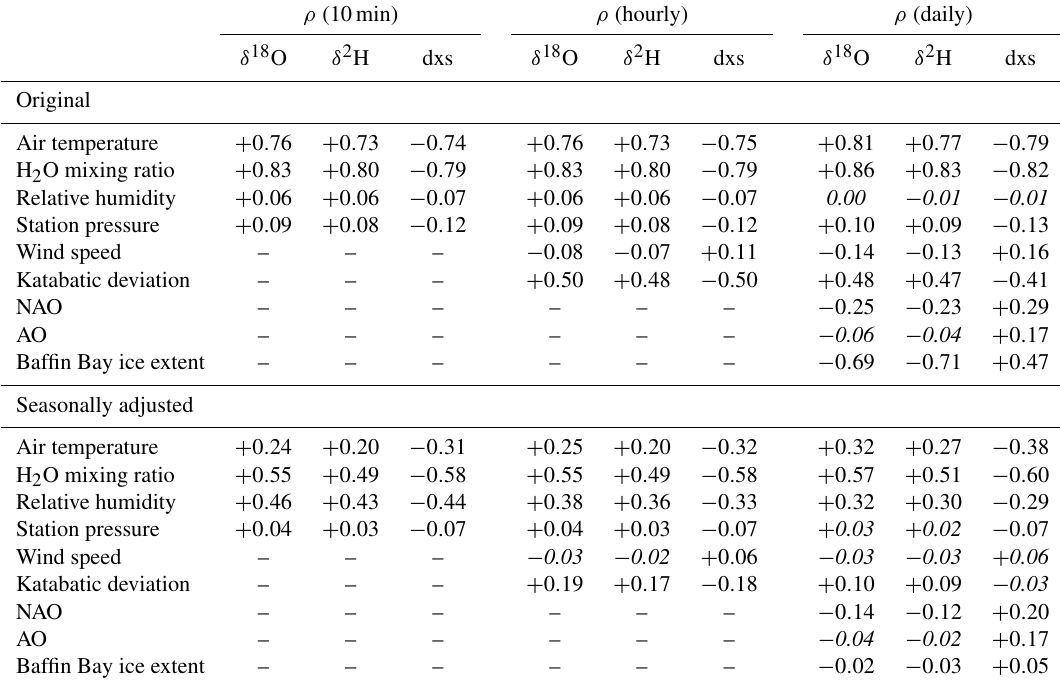
Table 2. Spearman correlation values between isotopic and meteorological variables at Thule. Two sets of correlations are reported here, namely analyses from the original data and analyses from the seasonally adjusted data in which the seasonal cycle was removed for isotopic, air temperature, mixing ratio, and sea ice data. Seasonally adjusting the data weakens nearly all correlations by removing the common response to seasonal change, but strengthens isotopic correlations with relative humidity. Correlations are given for all available levels of temporal aggregation, but some variables do not have data at finer resolutions. Temporal aggregation slightly strengthens correlations but does not generally change the order of variables when ranking by correlation strength. Due to the large sample sizes, all correlations are significant at p < 0 . 05, except for a few with very weak correlations (italicized). ρ (10min) ρ (hourly) ρ